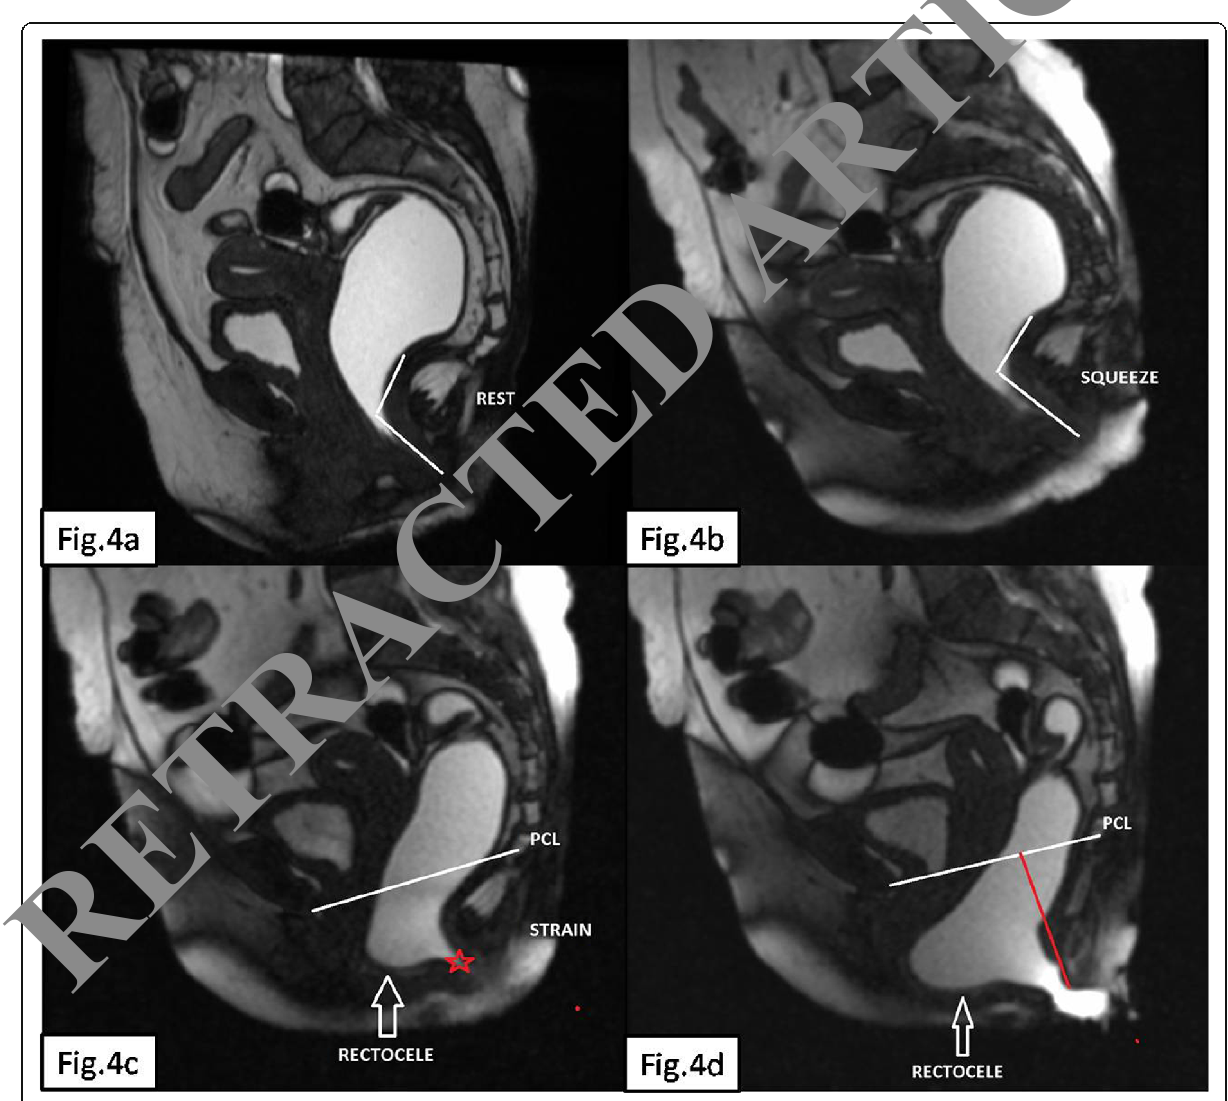
Fig. 4 Rectocele. There is reduction in ano-rectal angle from 109 ° at rest (Fig.4a) to 92 ° during squeeze ( b ). During strain ( c ), there is ano-rectal junction descent (red star) with formation of anterior rectocele (white arrow). In defecation phase ( d ), there is further descent of ano-rectal junction (> 6 cm) with further enlargement of anterior rectocele ( d ). This highlights the value of defecation phase which elicits or adds to various pelvic floor